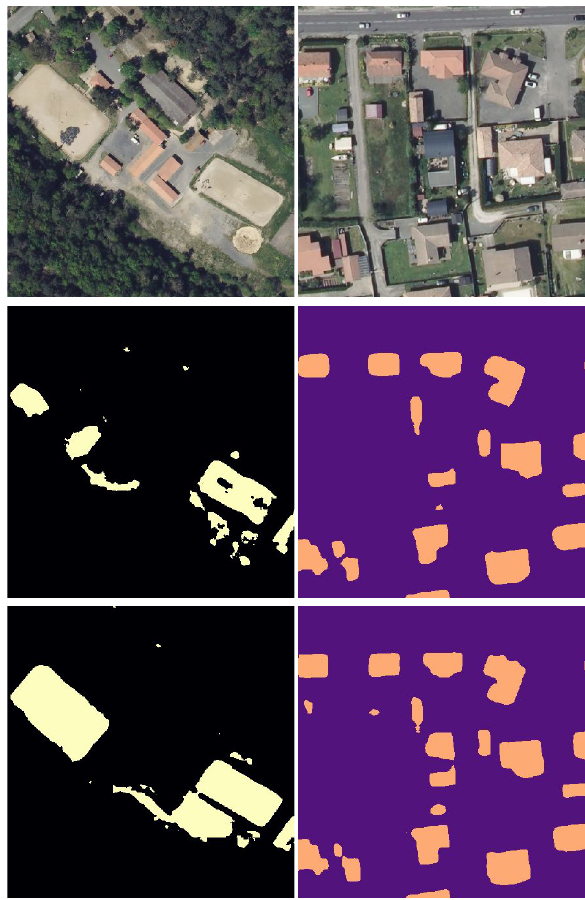
Figure 9. Comparison of U-Net and Deeplab binarized predictions (top: RVB images, middle: U-Net predictions and bottom: Deeplab predictions) for mineral materials and forest classes.